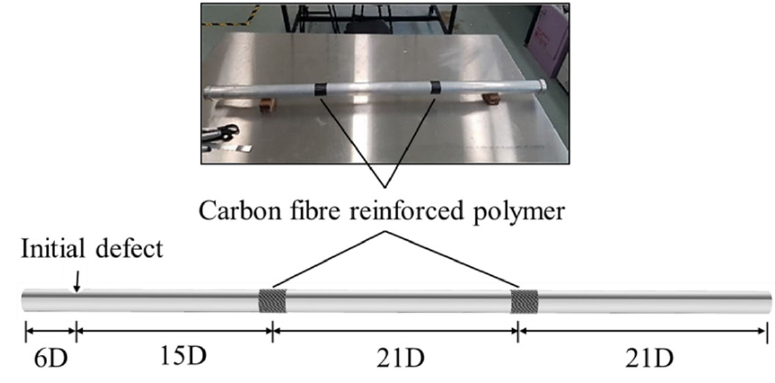
Figure 1. Comparison of experimental ( up ) [44] and numerical models ( down ).